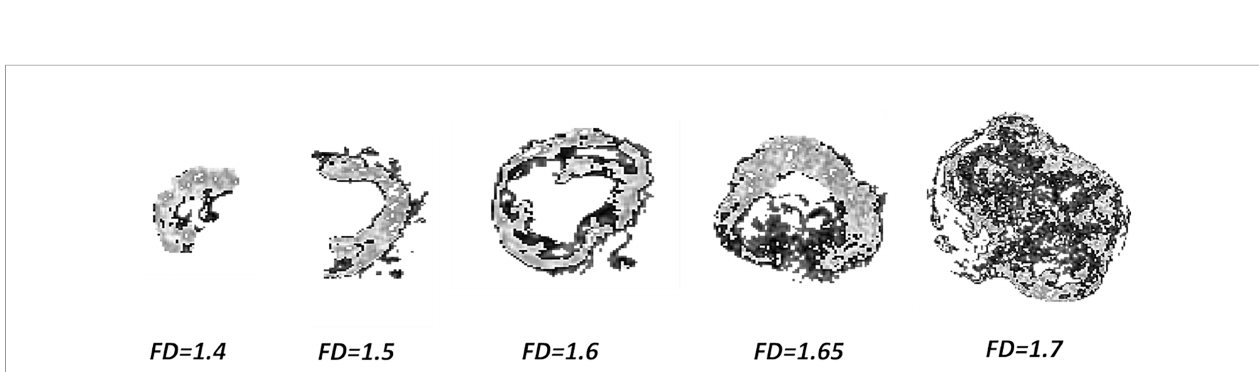
FIGURE 5 | Complexity of GTV to increasing maxFD 30 – 50 values: pixels in light gray indicating the subpopulation between 30% and 50% of the maximum intensity. GTV, gross tumor